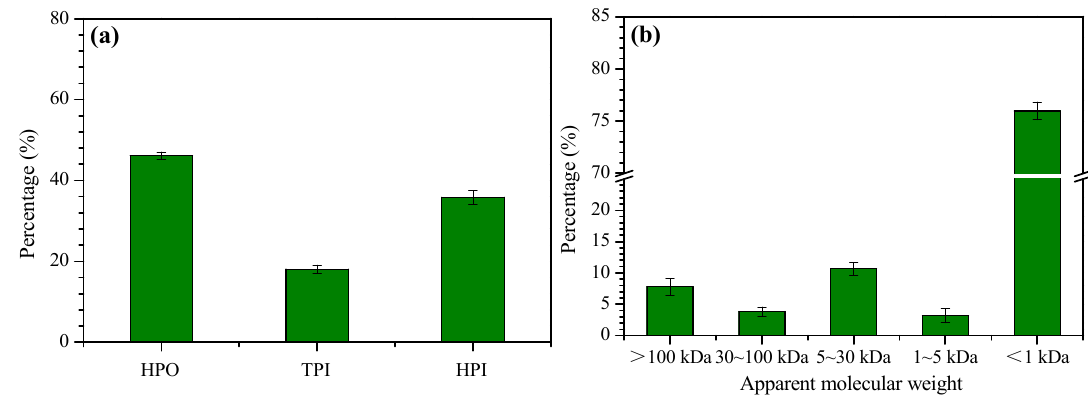
Figure 1. Hydrophobicity ( a ) and molecular weight distribution; ( b ) of natural organic matter (NOM) in raw water. Error bar indicates standard error of triplicate measurements.